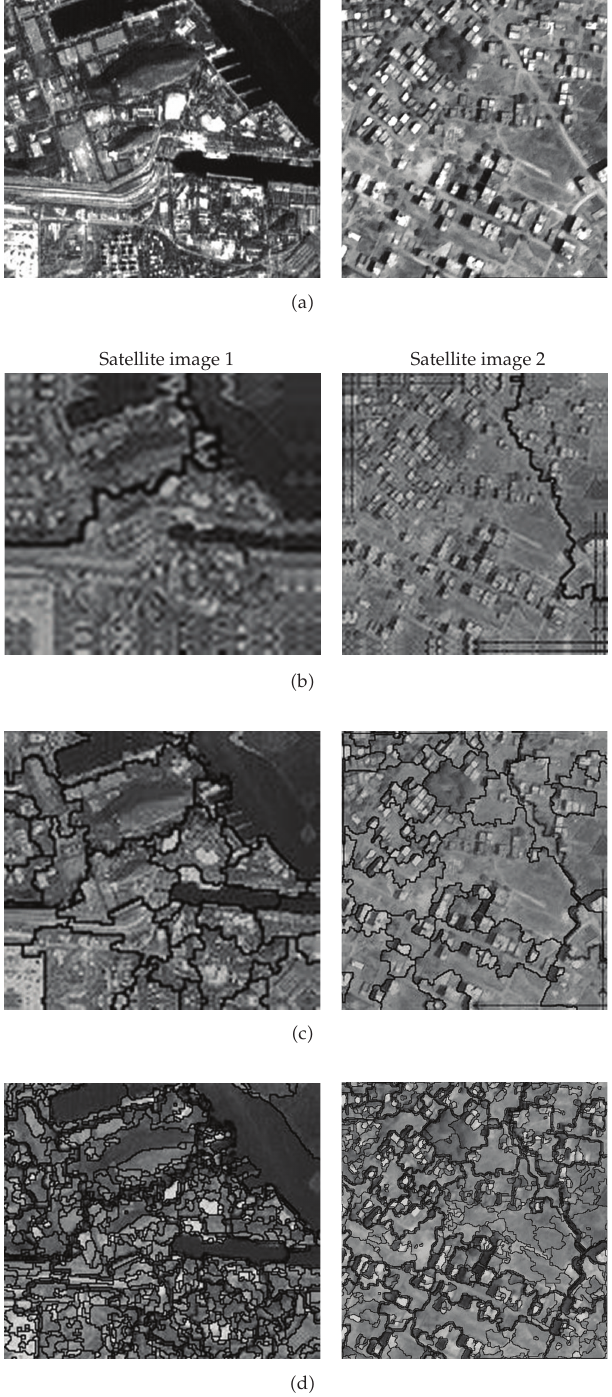
Figure 6: Final segmented Images (cid:3) a (cid:4) original image and (cid:3) b (cid:4) to (cid:3) d (cid:4) are the watershed imposed original images from level 2 to level 0 resolution